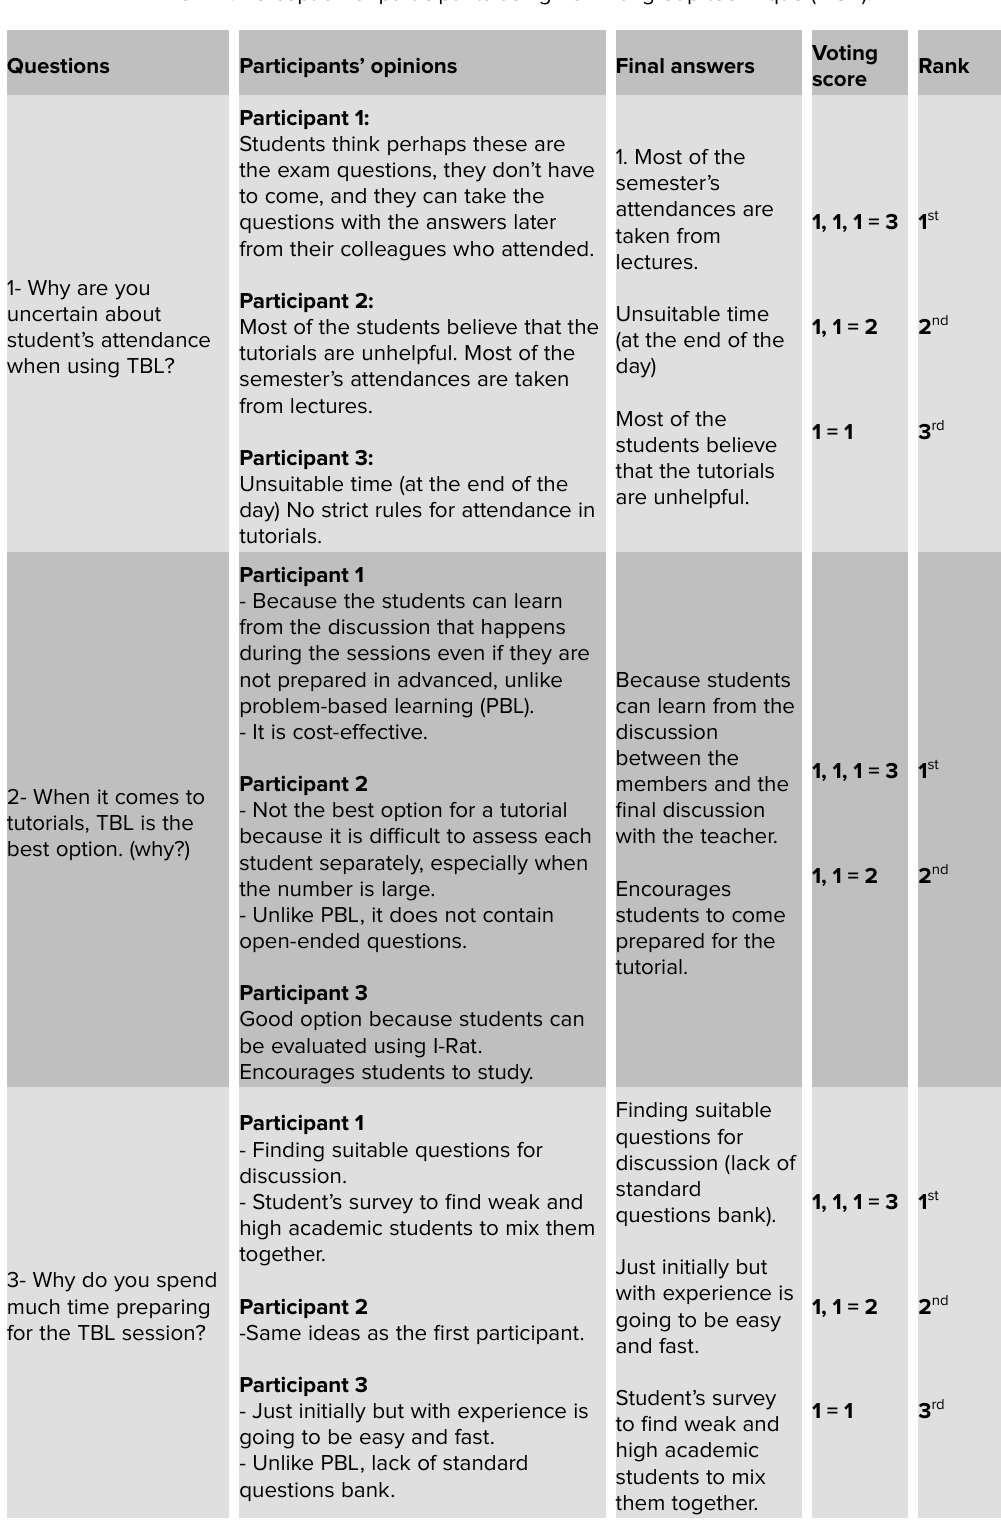
TABLE 2: Perception of participants using nominal group technique